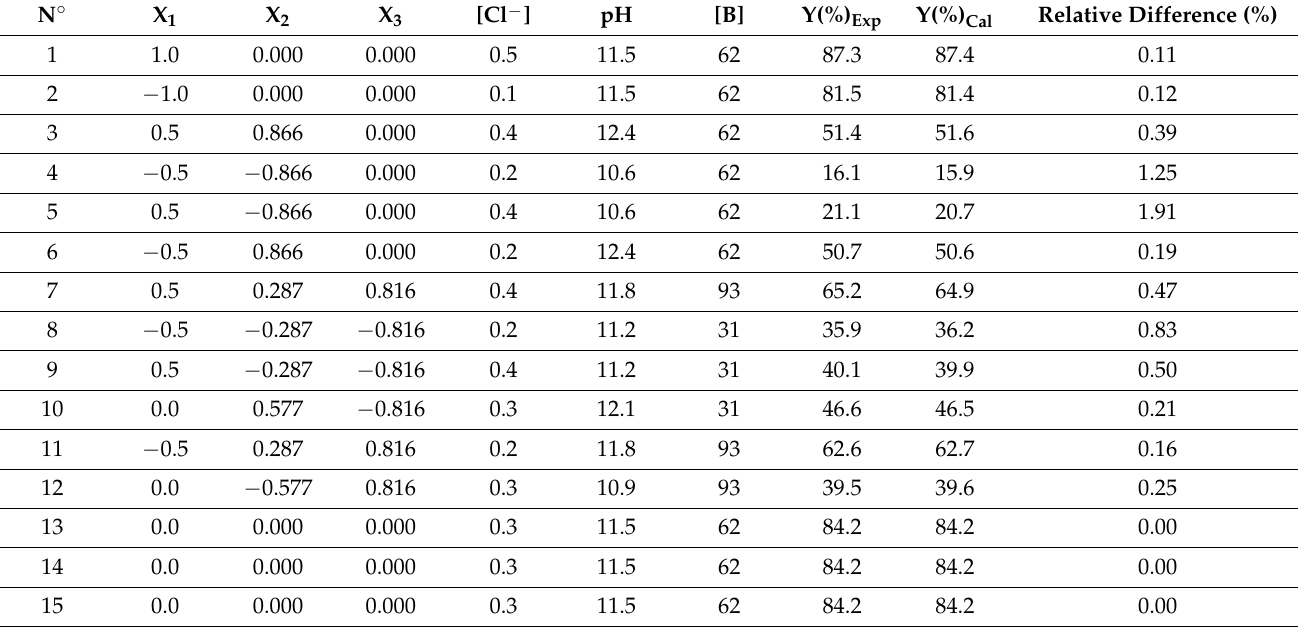
Table 5. Doehlert matrix and the obtained results.